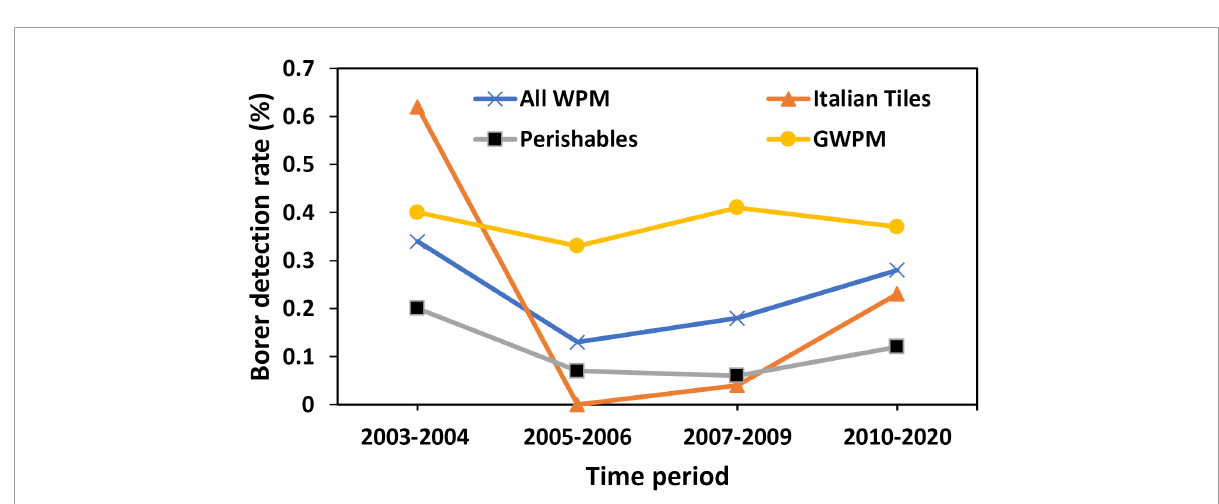
FIGURE9 Detection rates (%) of borer-infested WPM inspected as part of the AQIM program during four time periods from 2003 through 2020 that bracket when the US implemented ISPM 15 in 2005–2006. Data are presented for all AQIM inspections where WPM was recorded as well as for three major survey programs within AQIM: Italian tiles, perishables, and GWPM (general survey of all types of WPM associated with containerized maritime